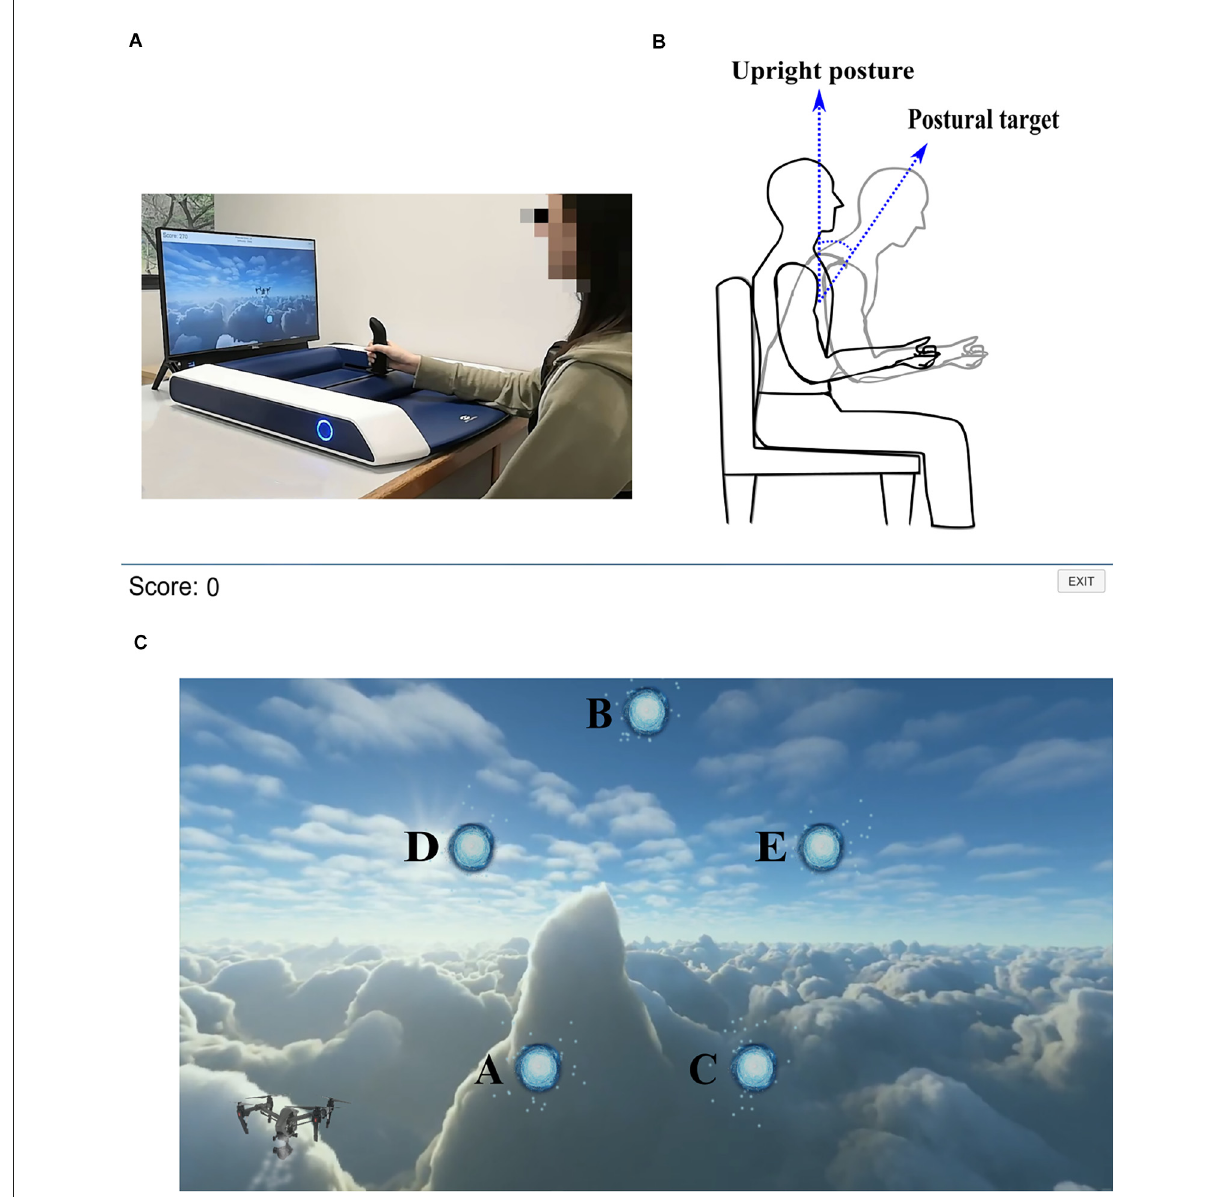
FIGURE1 (A) H-Man robot: Planar manipulandum called H-Man was used for making reaching movements. (B) Postural target: Desired postural target was set as 20 ◦ in the anterior direction from the initial upright posture. (C) Game screenshot: Point-to-point reaching movement-based game with five visual targets at A, B, C, D, and